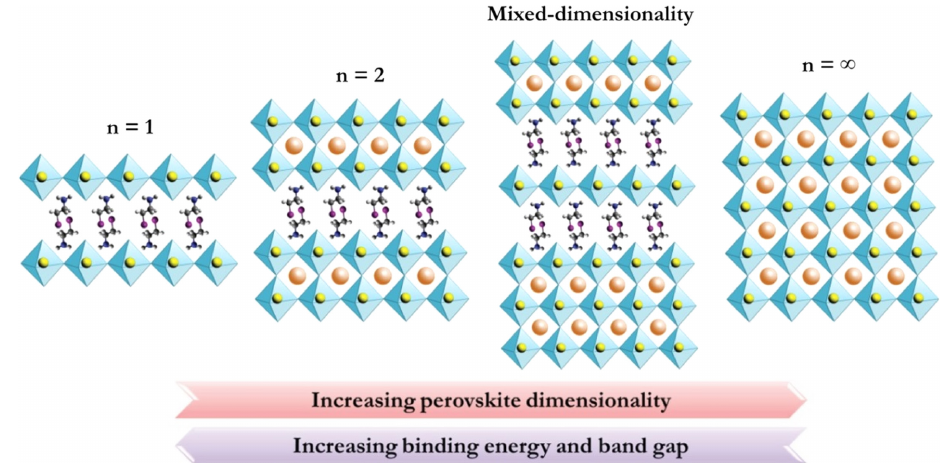
Figure 2: Schematic illustration showing the crystalline structure of 2D perovskites ( n = 1 and 2, where n represents the metal halide lattices), mixed-dimensionality perovskites and 3D perovskites ( n = ∞ ). Reprinted from Ref. [80] with permission from the